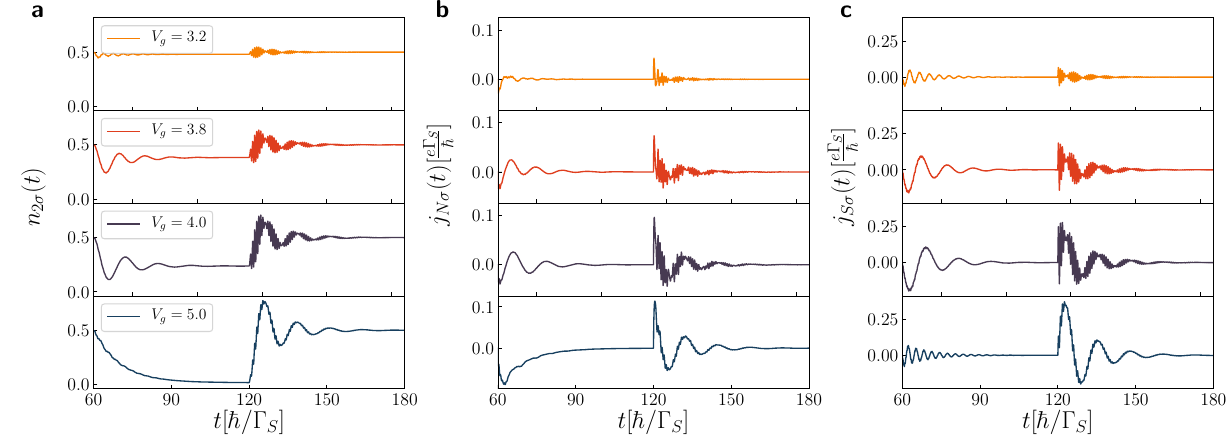
Figure 5. Dynamics imposed by quench of energy levels. The time-dependent occupancy n 2 σ ( t ) and the currents j N σ ( t ) , j S σ ( t ) driven by the step-like variation of the energy levels ε i σ 120 . Results are obtained for U ε i σ ε i σ , at t V g = + → several values of V g (in units of Ŵ S ) as